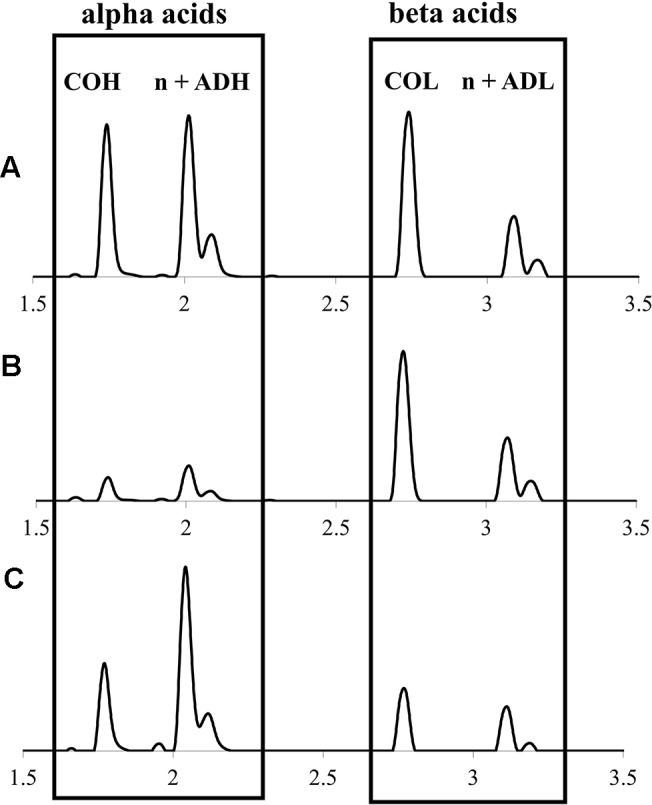
Representative UPLC-DAD chromatograms (320 nm) of hops cone soft resin diversity (alpha and beta acids) showing: (A)
lupuloides high alpha acid chemotype profile; (B)
lupuloides high beta acid chemotype profile; (C)
lupulus low co-humulone chemotype profile. COH, cohumulone; n + ADH, humulone + adhumulone; COL, colupulone; n + ADL, lupulone + adlupulone. Note n + ad isomers have traditionally been reported as one peak, due to past difficulties in their chromatographic resolution.